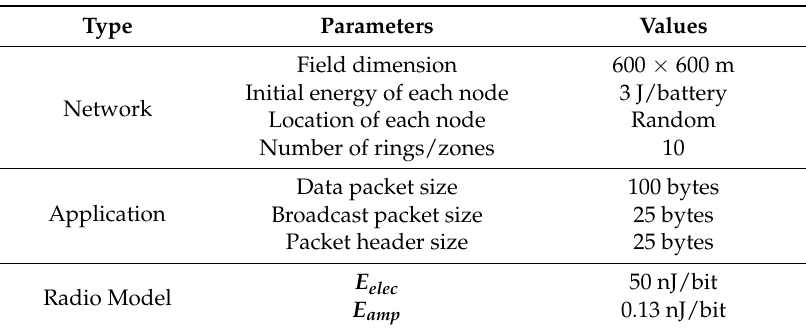
Table 2. Simulation setup and